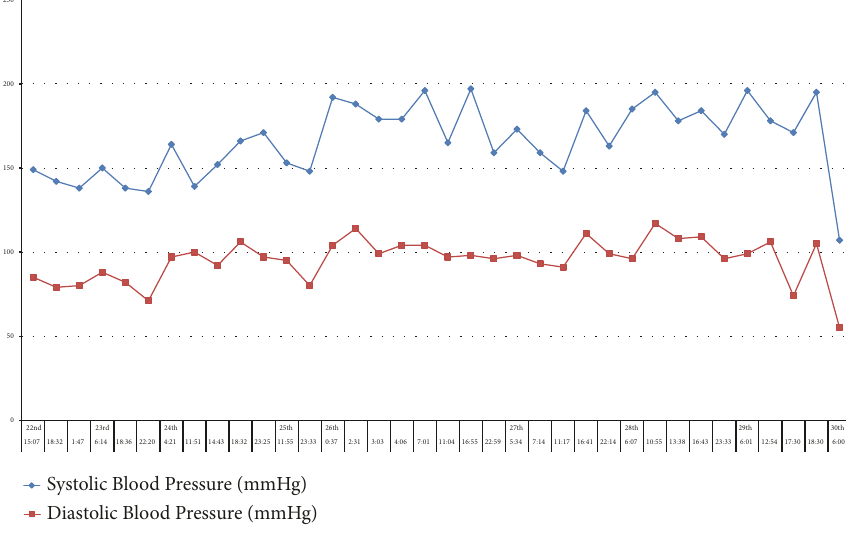
Figure 1: Patient’s blood pressure in the week preceding the onset of seizures.